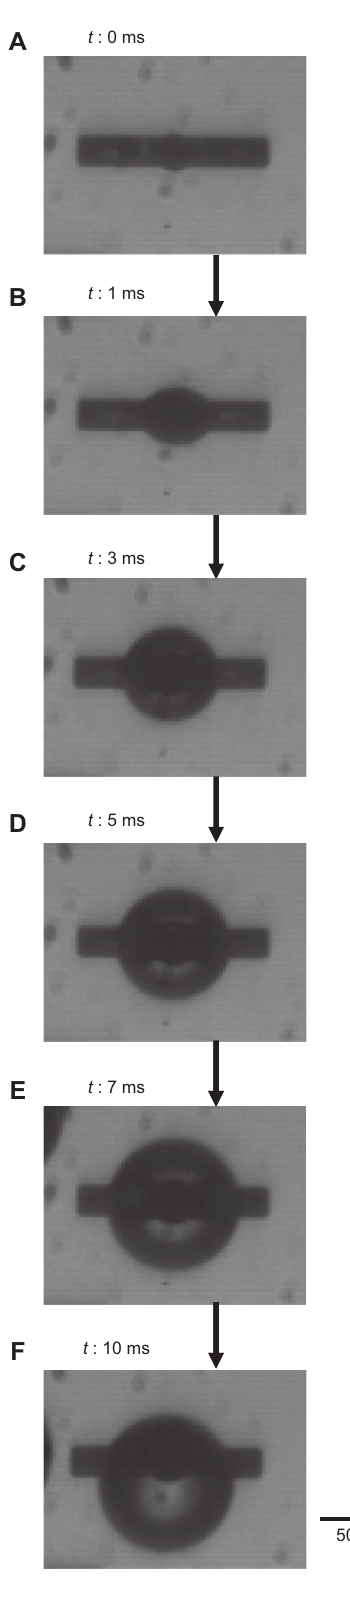
Figure 4 Sequential micrographs of the droplet detachment process from a slot outlet. t denotes time. The continuous phase flows from top to bottom in the